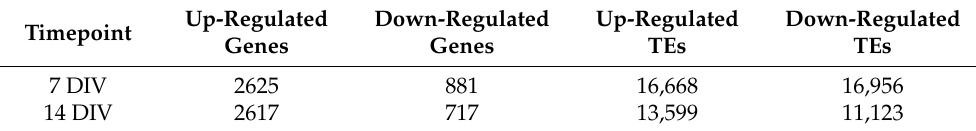
Table 1. Number of differentially expressed genes and TEs across each time